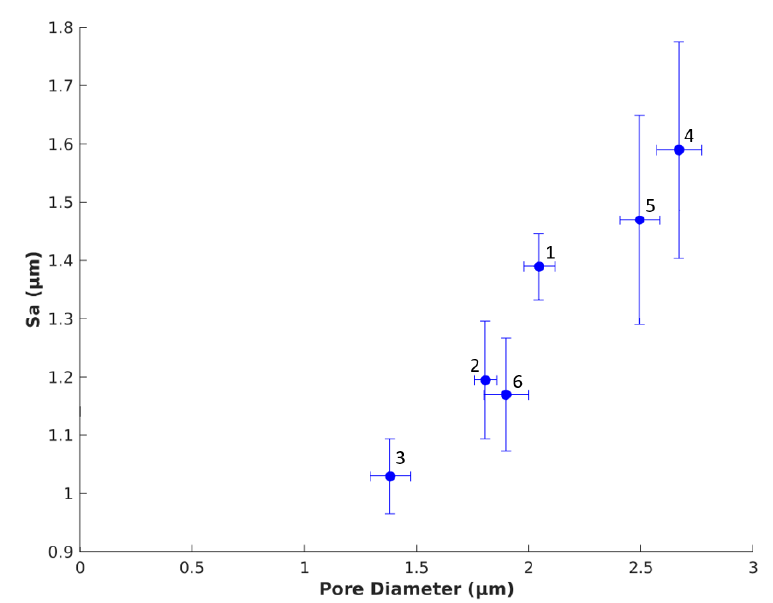
Figure 4. Relationship between pore diameter and Sa. Graph demonstrating the effect of change in pore diameter on surface roughness (Sa). As the pore diameter decreases (due to increased radial compression), the surface roughness also decreases. Labels 1–6 correspond to those identified in Tables 1 and 2.